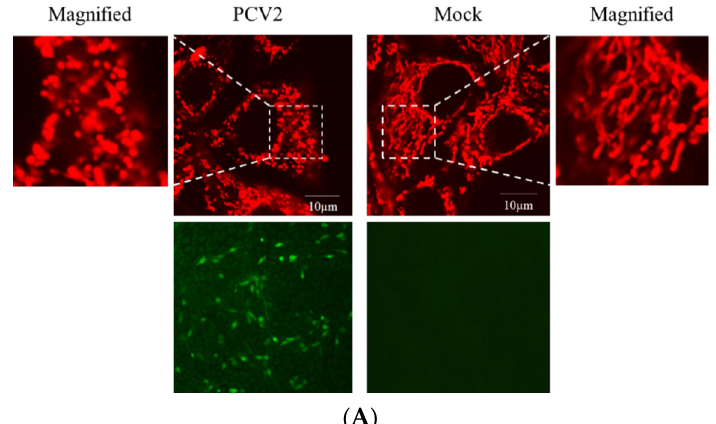
Figure 1. The PCV2-induced formation of mitophagosomes. PK-15 cells stably expressing EGFP-LC3 with PCV2 infection (MOI = 1) or without (Mock) at 48 hpi were examined for the formation of mitophagosomes. ( A ) The cells were stained with MitoTracker Red. Images on the right depict the magnified fields of the boxed areas in the merge images, showing colocalization of GFP-LC3 punctae (green) with mitochondria (Red). Images in the white boxes were enlarged 2.5-fold. Scale bars: 5 µ m. The black arrows indicate the colocalization of mitochondria and LC3 dots. ( B ) PCV2 infection induced a higher number of mitophagosomes in mitochondria compared to the mock control. ( C ) The cells were stained with Mtphagy Dye and Lyso Dye. Images on the right depict the magnified fields of the boxed areas in the merge images. Images in the white boxes were enlarged 2.5-fold. Scale bars: 5 µ m. The Mtphagy punctae (red) and Lyso puncta (green) were colocalized (red arrows), indicating the occurrence of mitochondrial autophagy (mitophagy). ( D ) PCV2 infection induced a higher intensity of Mtphagy Dye than the mock control. ( E ) Transmission electron microscopy images revealed the mitochondrial ultrastructure in PCV2-infected or mock-infected cells. In the magnified images, the red dotted boxes indicate swollen mitochondria ( a , b ) and an autophagic vacuole that contains mitochondria ( c , d ). In the mock-infected cells, the normal mitochondria were seen as clear cristae and filling matrix ( e – h ). The magnified images were enlarged twofold. Scale bars: 200 nm. Bar charts ( B , D ) show the mean ± SEM of three independent experiments. ** p < 0.01.